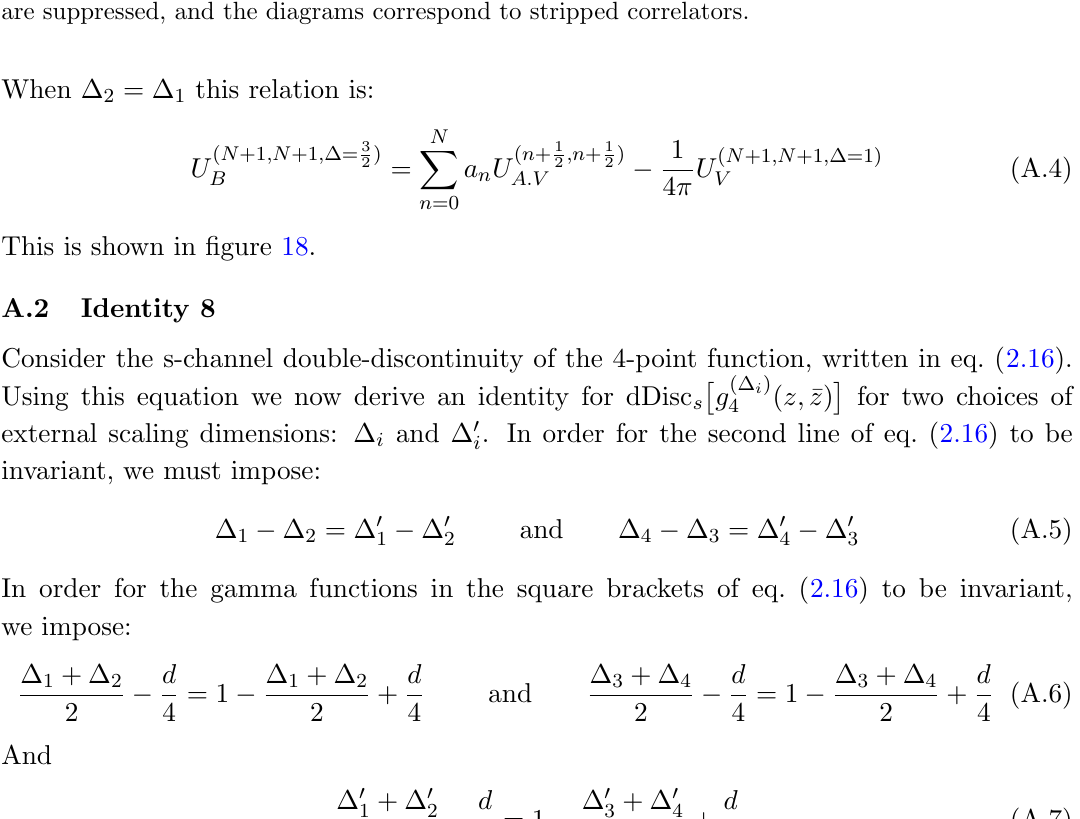
Figure 18 . Identity 7 0 gives a reduction of half-integer bubbles. The di(cid:11)erence between this (cid:12)gure and (cid:12)gure 8 is that here the external legs are integer scaling dimensions and the bubble is half- integer, whereas in (cid:12)gure 8 it is the opposite. The grey blob is general, the numerical coe(cid:14)cients are suppressed, and the diagrams correspond to stripped